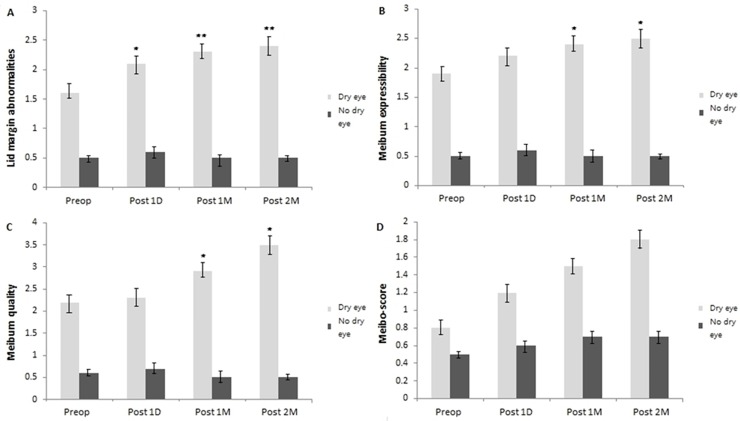
Change in lid parameters of MGD from preoperative value.(A) Change in lid margin abnormality scores from preoperative value. Lid margin abnormality scores were significantly higher in the dry eye group at 1 day, 1 and 2 months postoperatively compared to the no dry eye group (P <0.05). (B) Change in meibum expressibility from preoperative value. There was a statistically significant increase in the meibum expressibility at 1 and 2 months postoperatively and the dry eye group showed higher level than the no dry eye group (P <0.05). (C) Change in meibum quality from preoperative value. There was a statistically significant increase in the meibum quality at 1 and 2 months postoperatively and the dry eye group showed higher level than the no dry eye group (P <0.05). (D) Change in meibo-score from preoperative value. Meibo-score was higher in the dry eye group at 1 day, 1 and 2 months postoperatively compared to the no dry eye group. Each value represents the mean ± standard error of the mean (SEM). Significance was evaluated with random-effects analysis of variance (ANOVA) model; p values of <0.05 were considered statistically significant. ***P < .001, **P < .01, *P < .05, using a linear mixed model with post hoc analysis, or generalized estimating equations model.